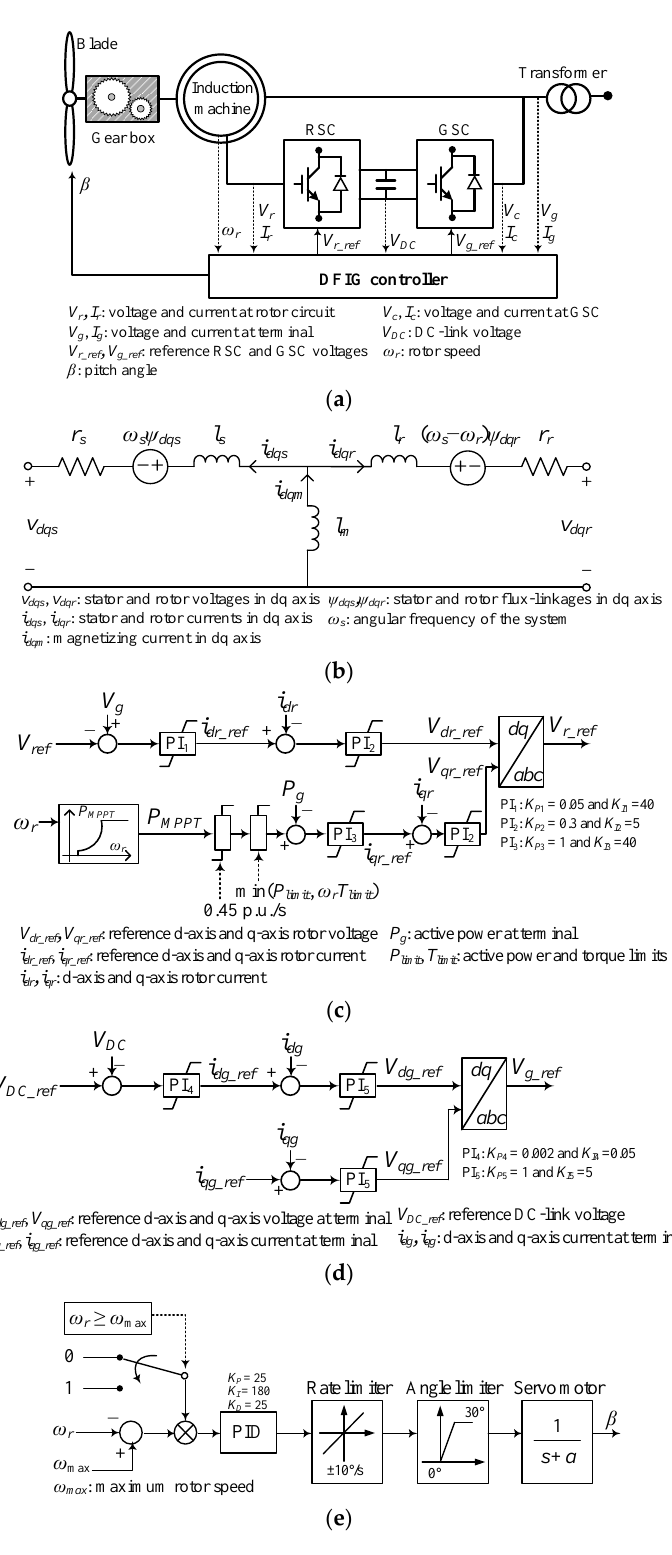
Figure 1. Typical topology and pitch control scheme of a doubly-fed induction generator (DFIG). ( a ) Typical configuration of a DFIG; ( b ) Electrical equivalent circuit of an induction generator; ( c ) Simplified rotor-side converter (RSC) control scheme; ( d ) Simplified grid-side converter (GSC) control scheme; ( e ) Pitch-angle control scheme used in this paper. MPPT: maximum power point tracking.